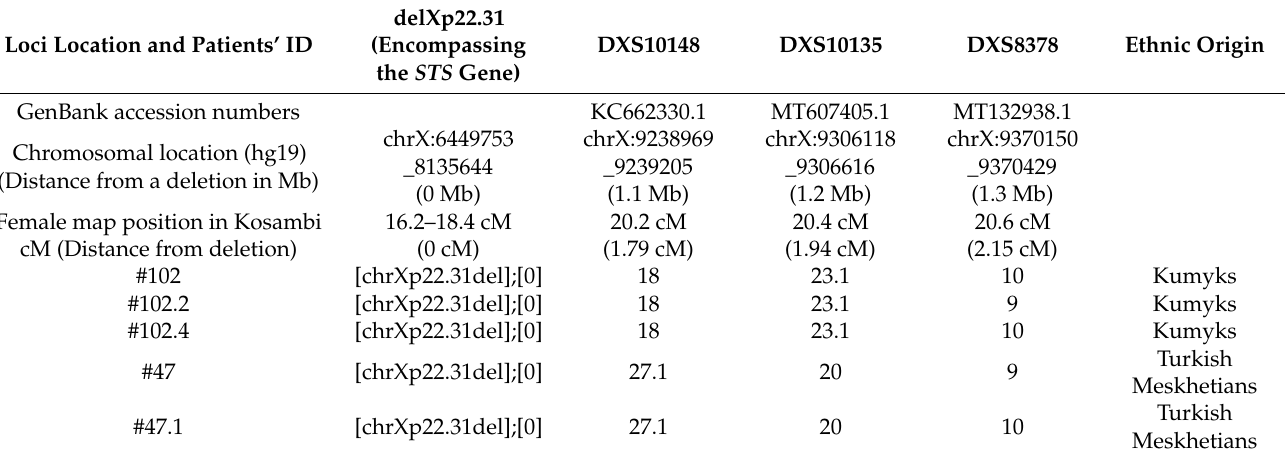
Table 2. Genotypes by the deletion Xp22.31del and three STR markers were revealed in patients from families #47 and #102 and STR markers’ chromosomal location.